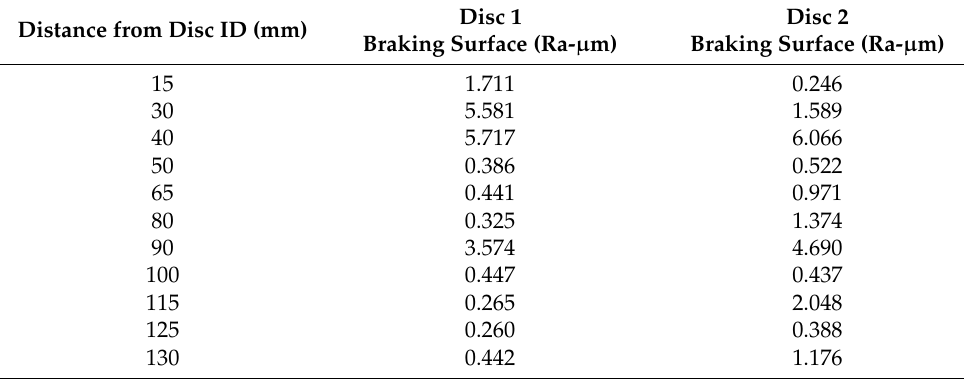
Table 4. Surface roughness measurements.